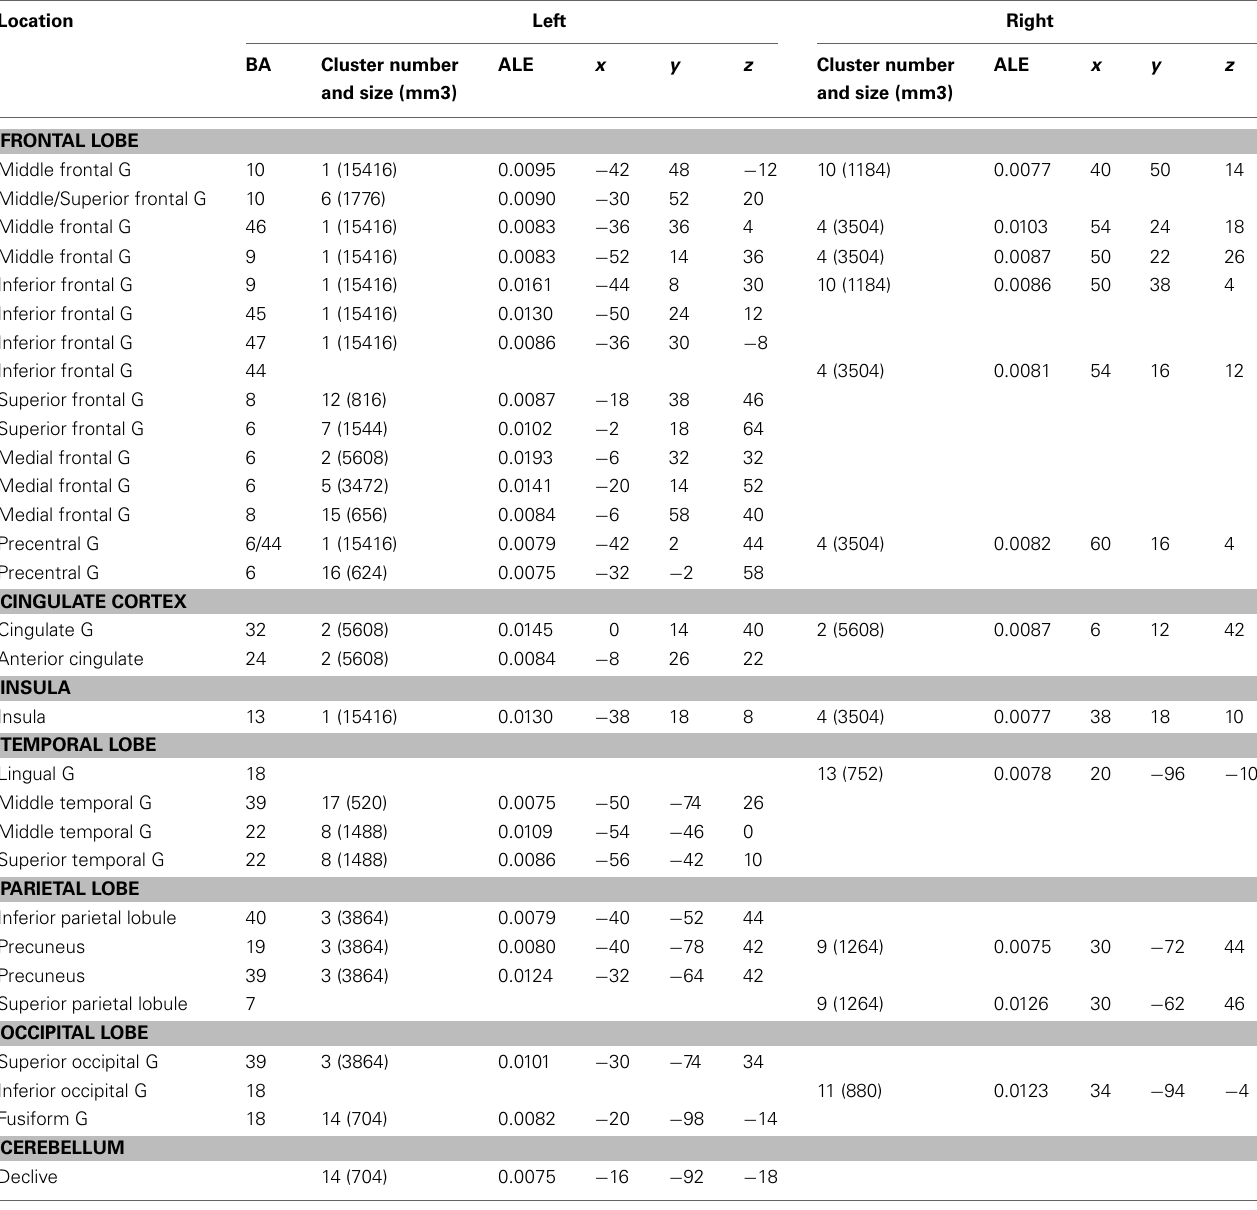
Table 3 | Locations of clusters with significant ALE values for combination tasks.